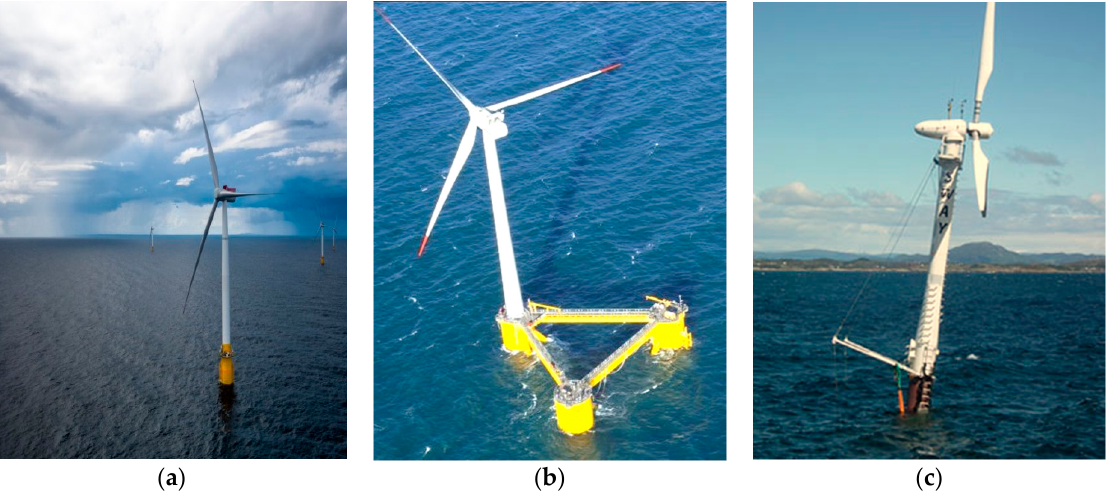
Figure 1. Floating offshore wind concepts: ( a ) Hywind [13] ( b ) WindFloat [14] and ( c ) SWAY [15]. Floating wind energy will be necessary for the UK to meet net-zero emissions by